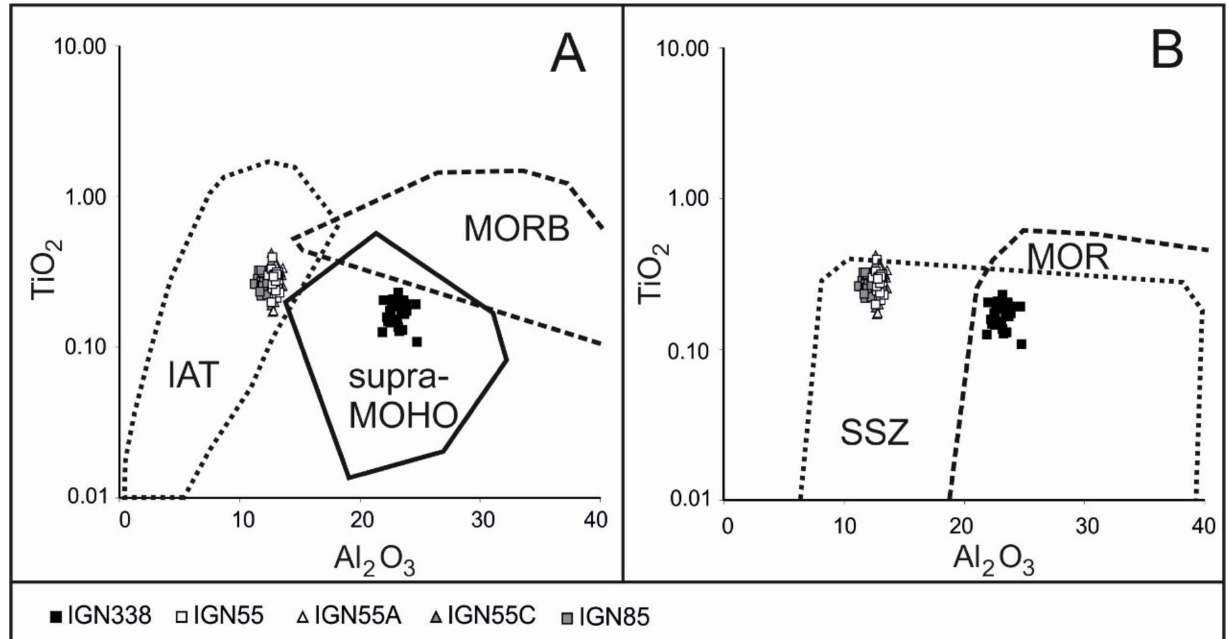
Figure 6. TiO 2 –Al 2 O 3 relationships in chromitites of Sebuku Island. ( A ) composition of the studied chromite, compared with the field of spinels from IAT, MORB mantle peridotites and supra-Moho cumulates (compositional fields from Kamenetsky et al. [44]; Garuti et al. [45]; Zaccarini et al. [46], ( B ) plot of chromite analyses, in comparison with the compositional fields of spinels from SSZ and MOR